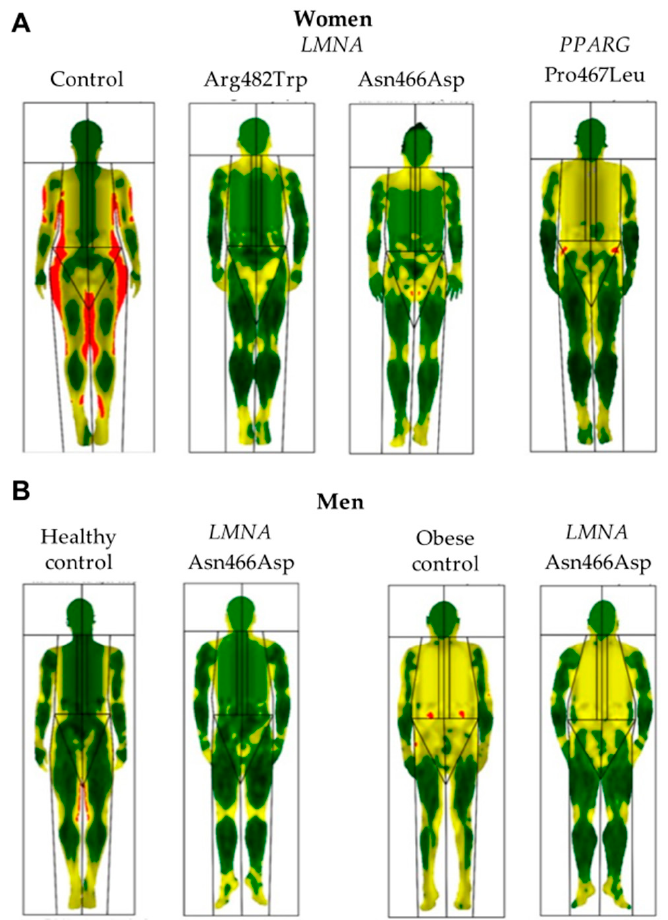
Figure 4. Comparative body composition determined by Dual-Energy X-ray Absorptiometry. Com- parative, colour-mapped, total body composition scans via whole-body Dual-Energy X-ray Absorp- tiometry of patients with FPLD2, FPLD3 and non-lipodystrophic subjects. Green represents an area of low-level % fat (0–25%), yellow an area of medium-level % fat (25–60%), and red an area of high-level % fat (60–100%); ( A ) Less-pronounced fat loss can be observed in the woman with PPARG -associated FPLD in comparison with the women with FPLD2. Differences can be seen even when comparing different variants within exon 8 of the LMNA gene; ( B ) Differences in the distribution of adipose tissue are less evident in men with FPLD2 when compared with age and BMI-matched healthy or obese